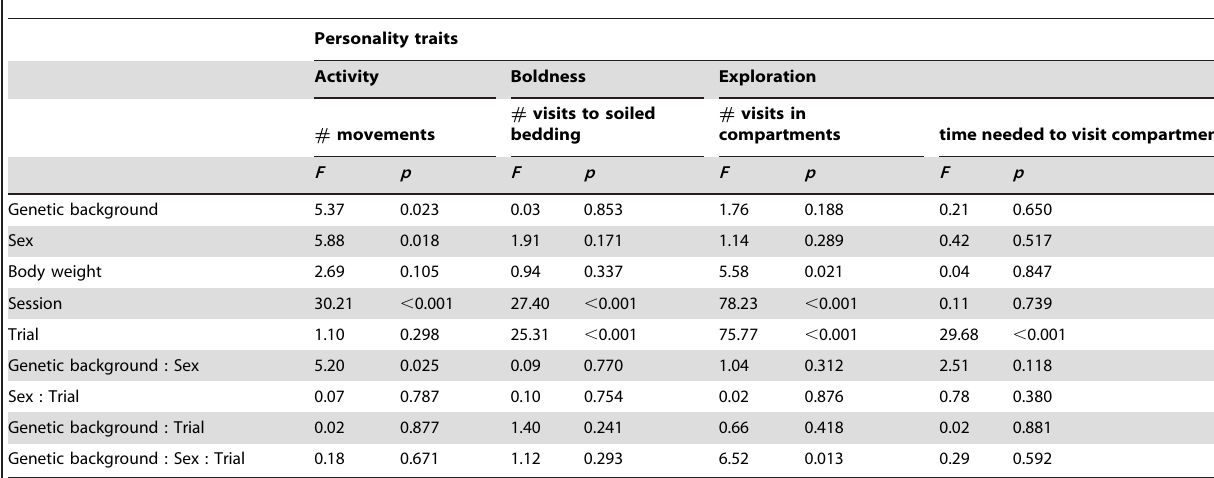
Table 2. Mixed model analysis of the personality traits showing individual consistency.